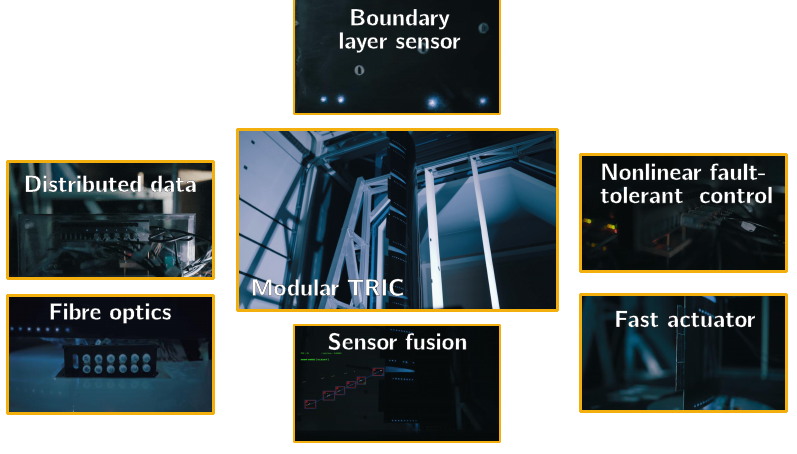
Figure 9. The SmartX integration